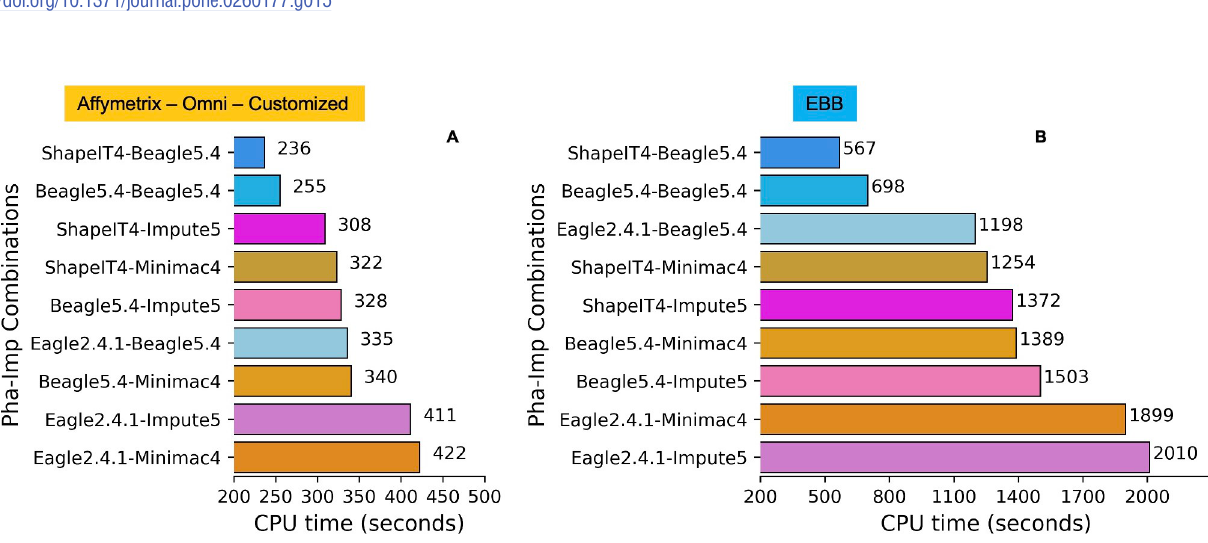
Fig 16. CPU run time of imputation and phasing combinations tested. Average run time for each of the 9 phasing and imputation software combinations. (A) Run time comparison of each combination in Affymetrix, Omni, Customized datasets. (B) Run time comparison of each combination in the EBB